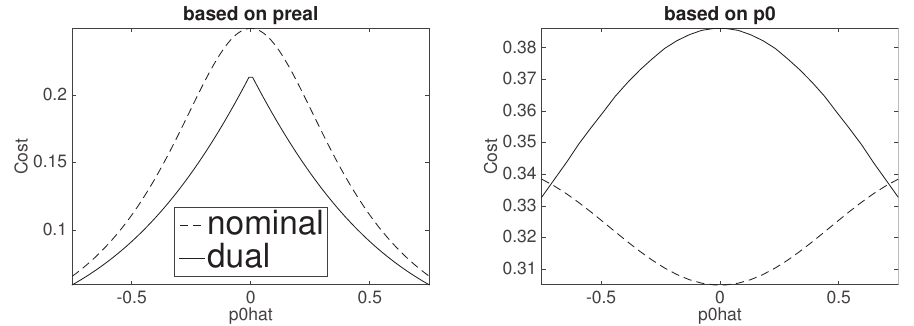
(cid:104) (cid:105) 1 + 1 ( ˆ p ) 2 u 2 u ∗ . The left graph displays the cost resulting from 1 0 1 2 2